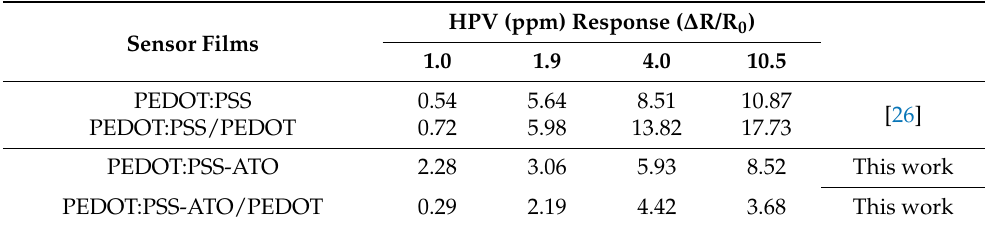
Table 1. Resistance response data of PEDOT:PSS, PEDOT:PSS/PEDOT, PEDOT:PSS-ATO, and PEDOT:PSS-ATO/PEDOT films under different concentrations of HPV.